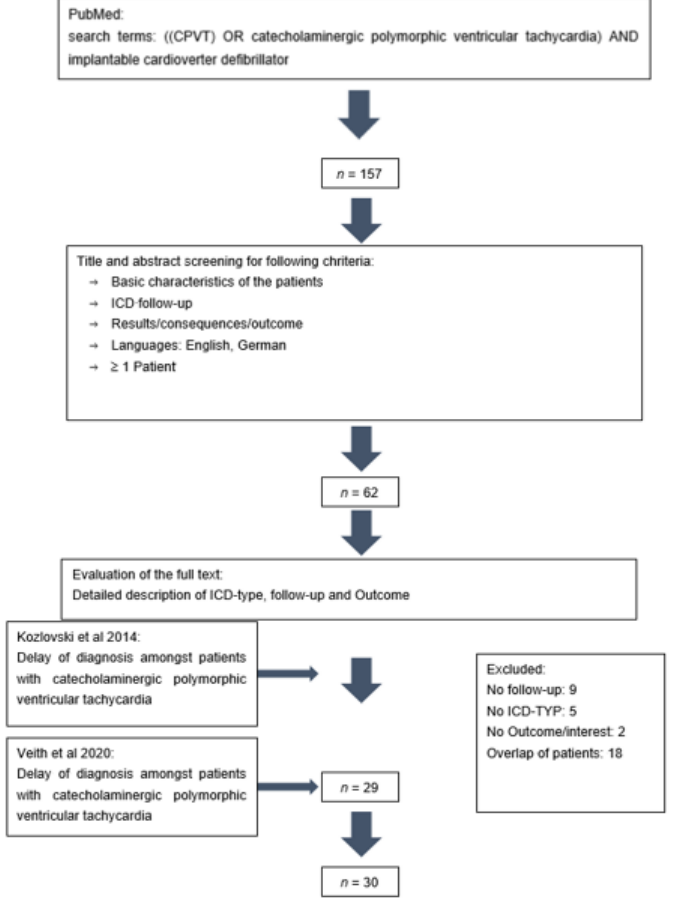
Figure 1. Literature review using the PRISMA